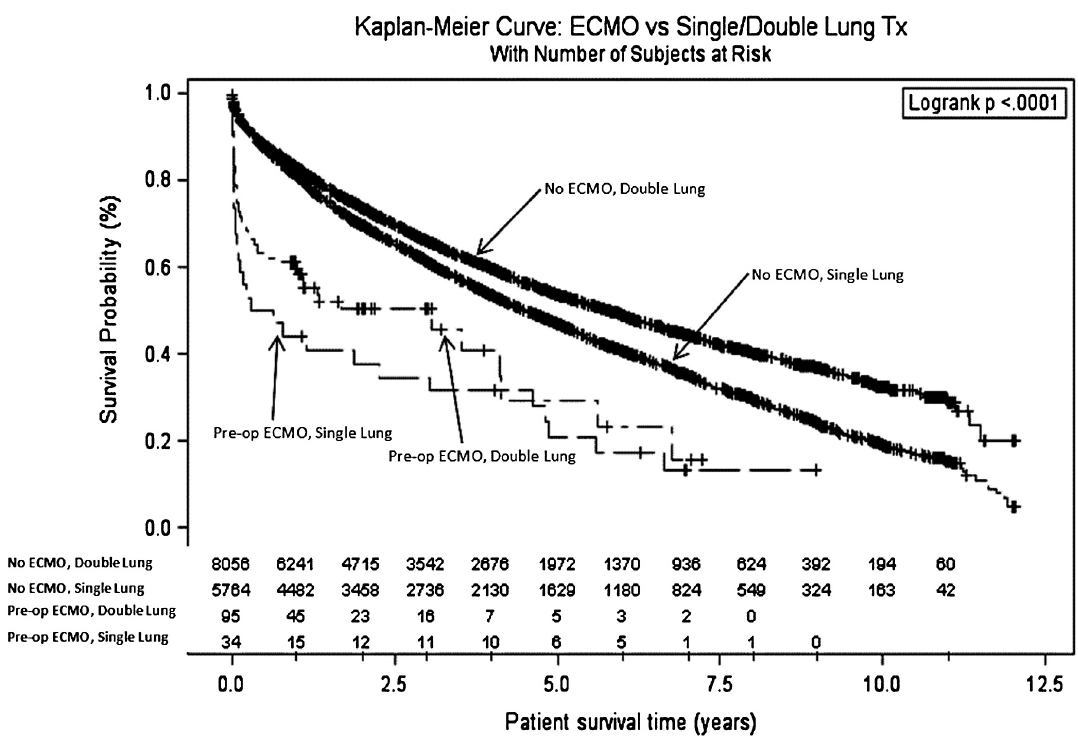
Figure 3. Kaplan – Meier Curve: Comparing survivals of patients on pretransplant ECMO with those that were not on ECMO separated by type of transplant performed (single vs double lung).